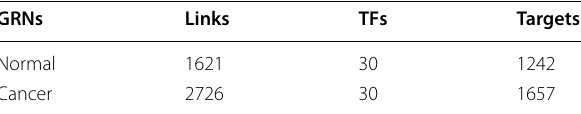
The genes are sorted by the DR values. Genes in bold refer to GC-related genes; genes in italic refer to